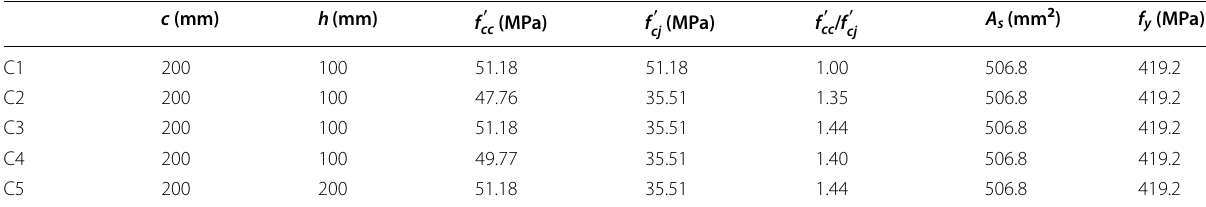
Table 1 Specimens